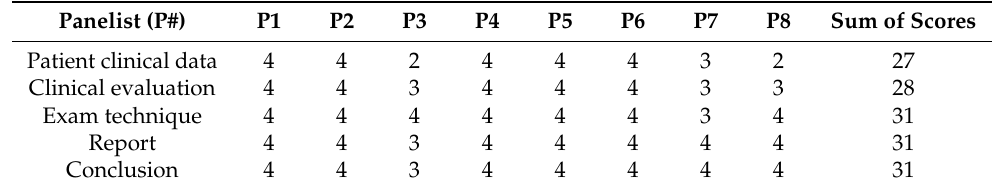
Table 3. Panelists’ single scores and sum of scores for RC restaging reports (second round). Panelist